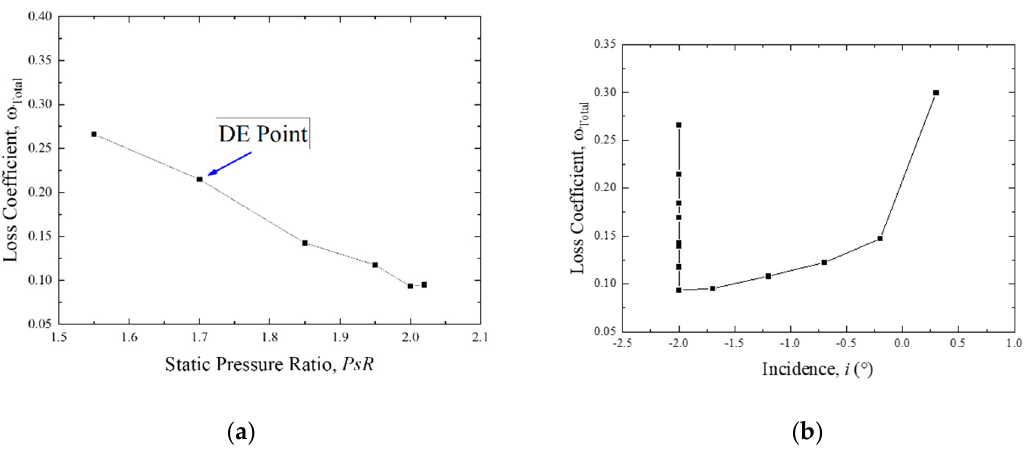
Figure 3. Tandem blade performance at inlet Mach number 1.2. ( a ) Static pressure ratio-loss characteristic, ( b ) Incidence-loss characteristic.